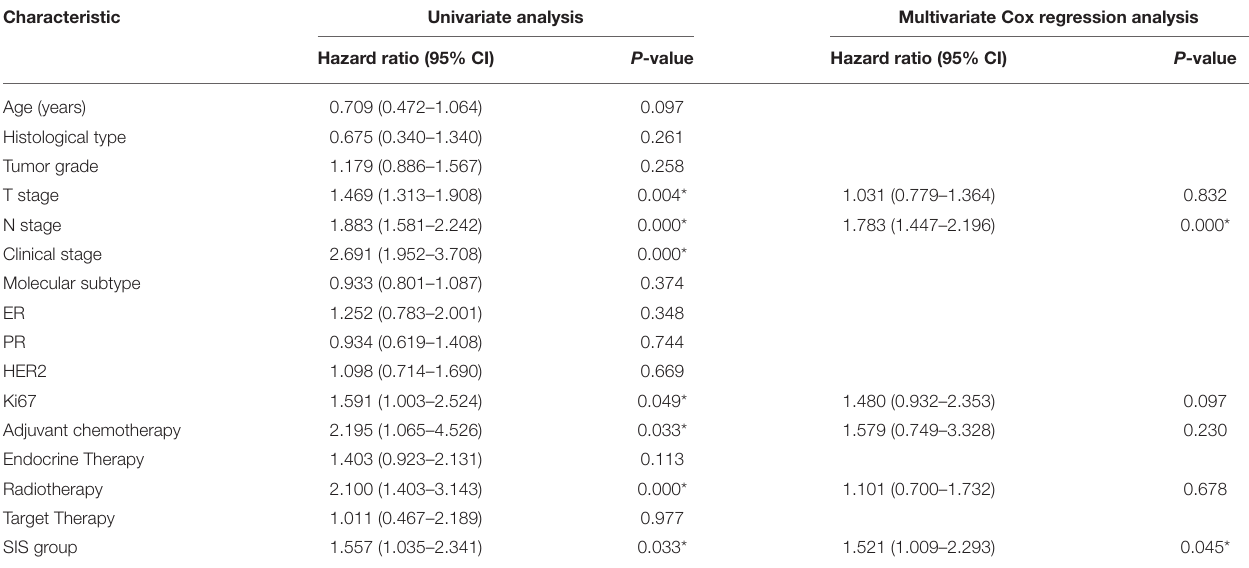
TABLE 4 | Univariate and multivariate analyses of distant metastatic free survival in the training set.